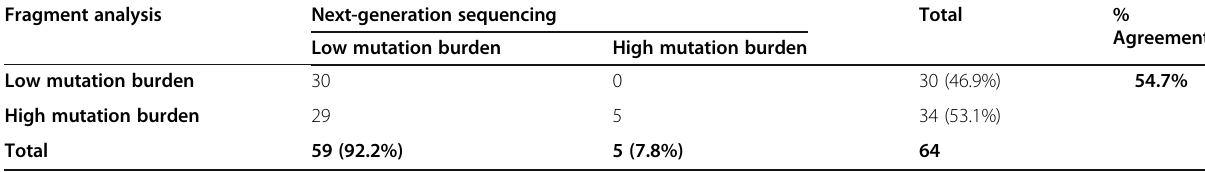
Table 2 Concordance of FLT3 ITD mutation burden classification between NGS and fragment analysis Fragment